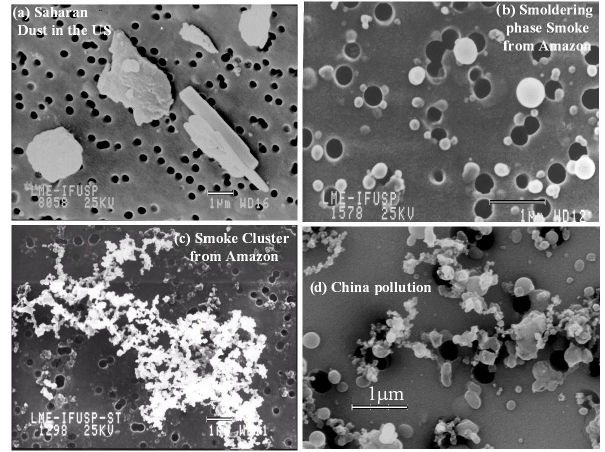
Figure 1. Scanning electron microscope image of ambient air aerosols (courtesy Jose Vanderlei Martins, Institute of Physics of the University of Sao Paulo,